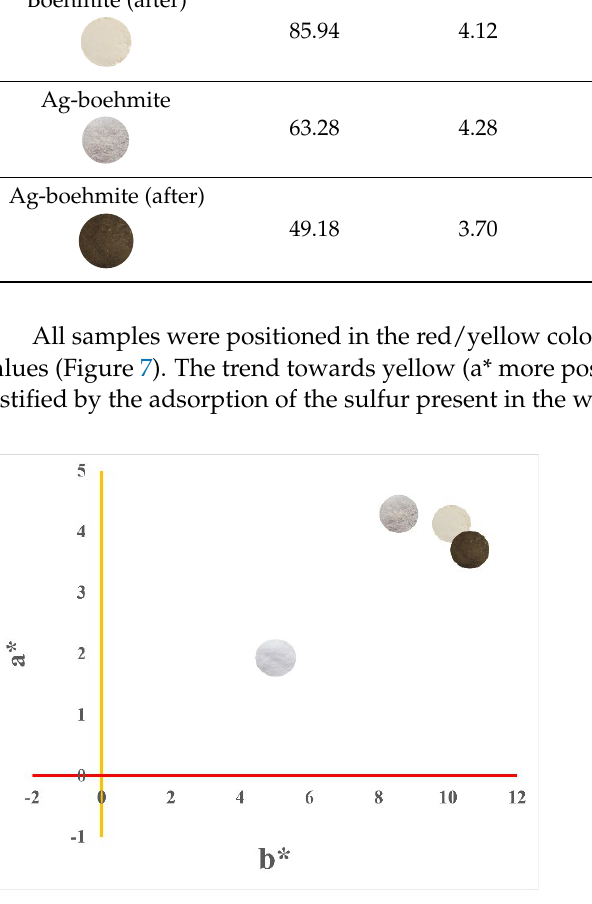
Table 6. Colorimetric parameters of samples before and after water treatment. Sample